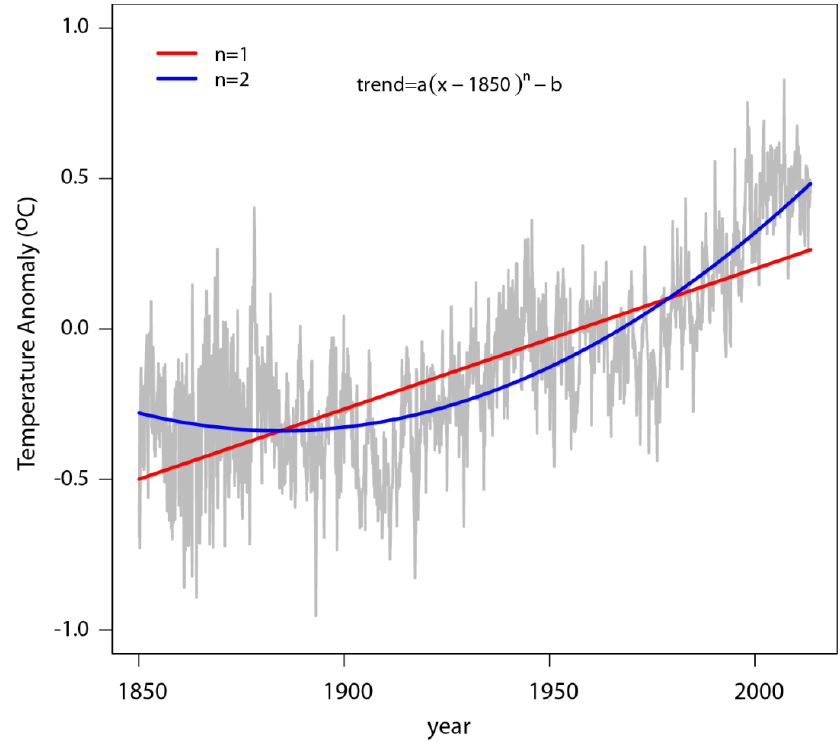
Figure 1. Comparison of linear and quadratic temperature trendlines to HADCRUT4